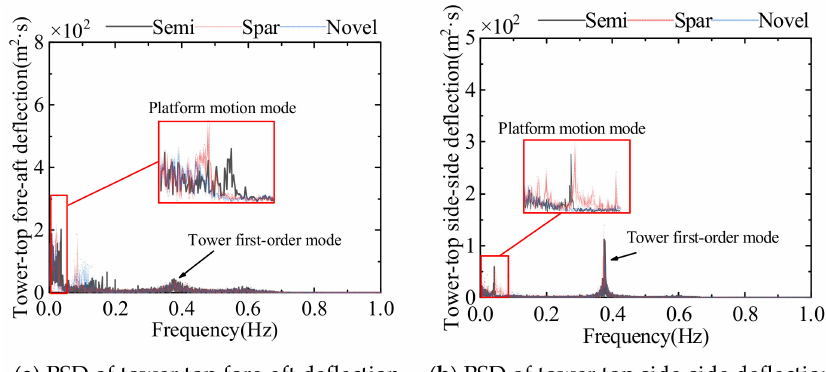
Figure 30. Power spectral density of tower top deflection of three FOWTs. Loads at the Tower Base